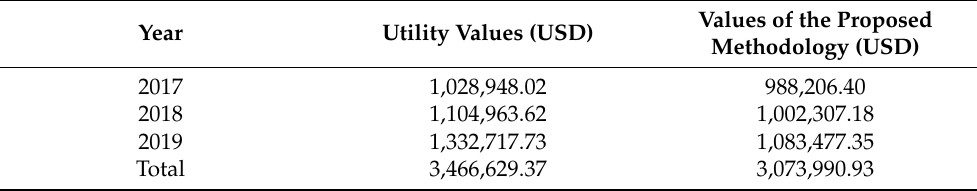
Table 2. Monthly compensation amounts for 2017, 2018, and 2019.